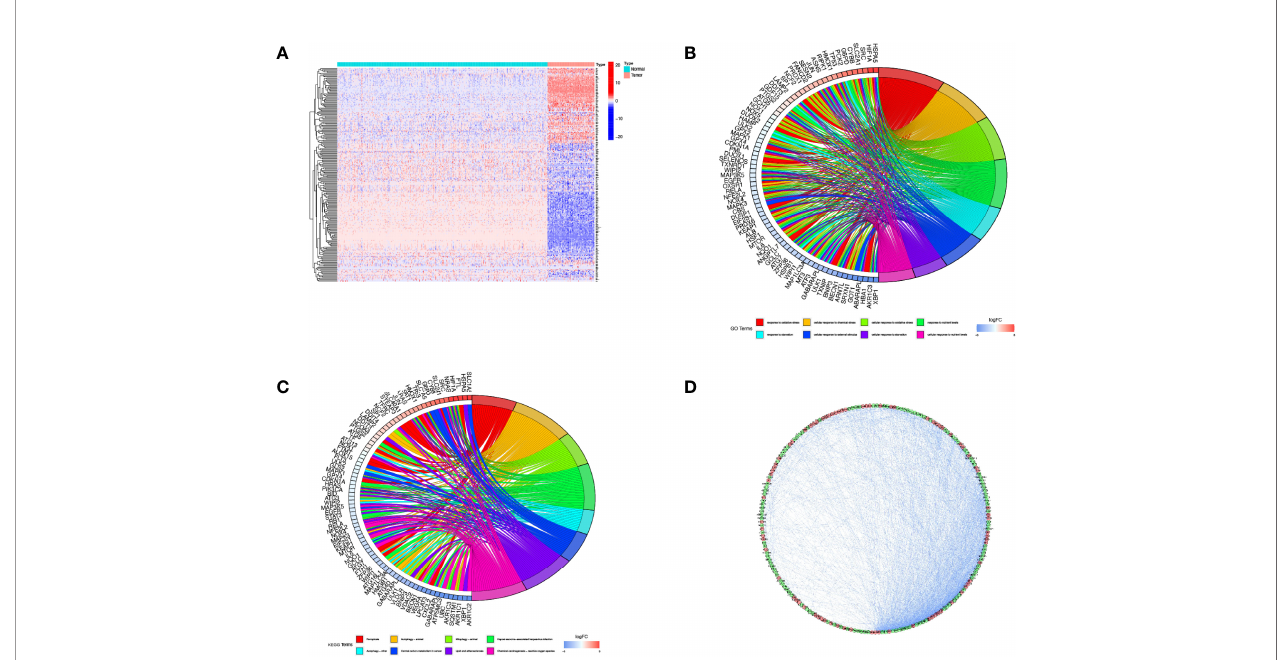
FIGURE 1 | Screening of DEFRGs between osteosarcoma and normal tissues. (A) Heatmap for 227 DEFRGs. DEFRGs with upregulation, downregulation, and no signi fi cant difference were indicated by red, blue, and white dots, respectively. (B) GO enrichment analysis of DEFRGs. (C) KEGG pathway enrichment analysis of DEFRGs. (D) Protein-protein interaction network of DEFRGs. DEFRGs, differentially expressed ferroptosis-related genes; GO, Gene Ontology; Kyoto Encyclopedia of Genes and